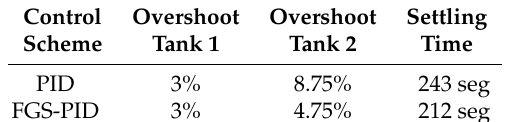
Table 7. Experimental results of the controllers’ transient response.